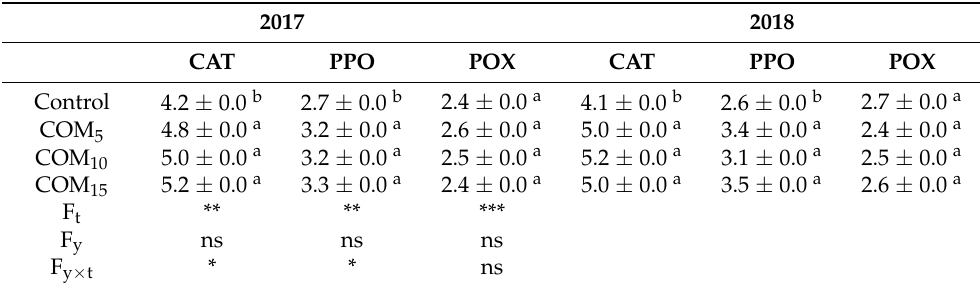
Table 4. Effect of compost on antioxidant enzyme activities (unit mg − 1 protein) in the leaves of river saltbush plants.